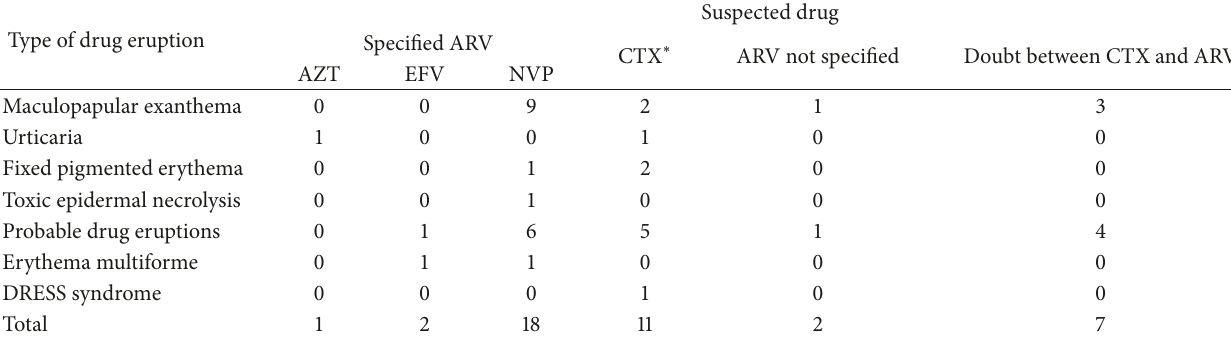
Table 2: Drugs suspected depending on the nature of the drug